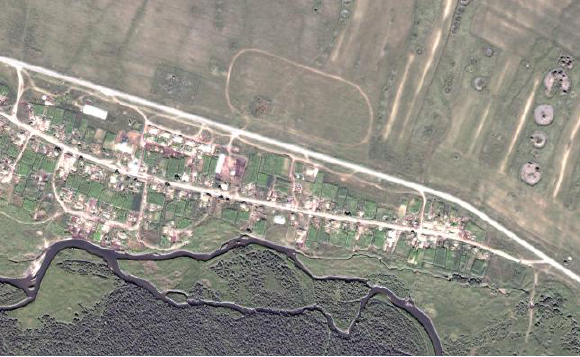
Figure 2: Processed IKONOS image segment showing the village of Tuekta (white box in figure